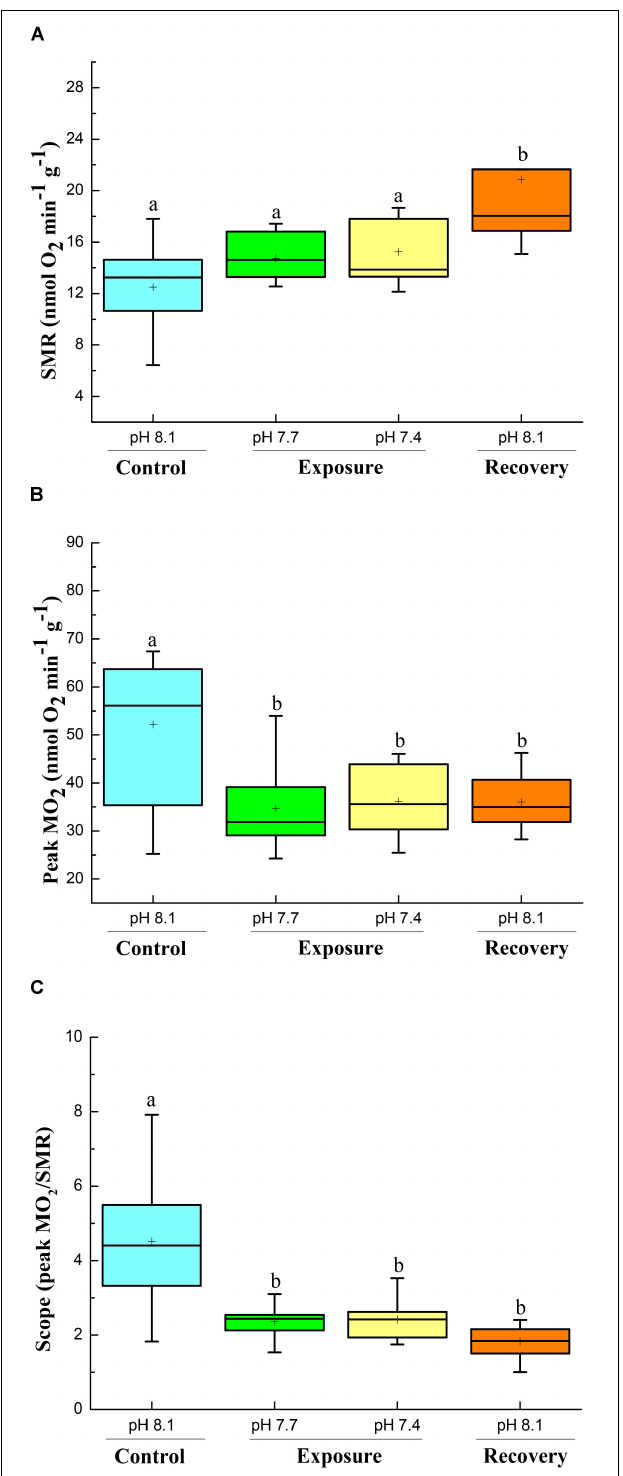
FIGURE 1 | SMR (A) , Peak MO 2 (B) , and scope (C) of C. pagurus at varying pH conditions (pH 8.1 control), pH 7.7, pH 7.4, and pH 8.1 (recovery). Data were analyzed using one-way ANOVA. Significance was reported at the P < 0.05 levels, Different letters indicate that the value was significantly different from the control pH 8.1.